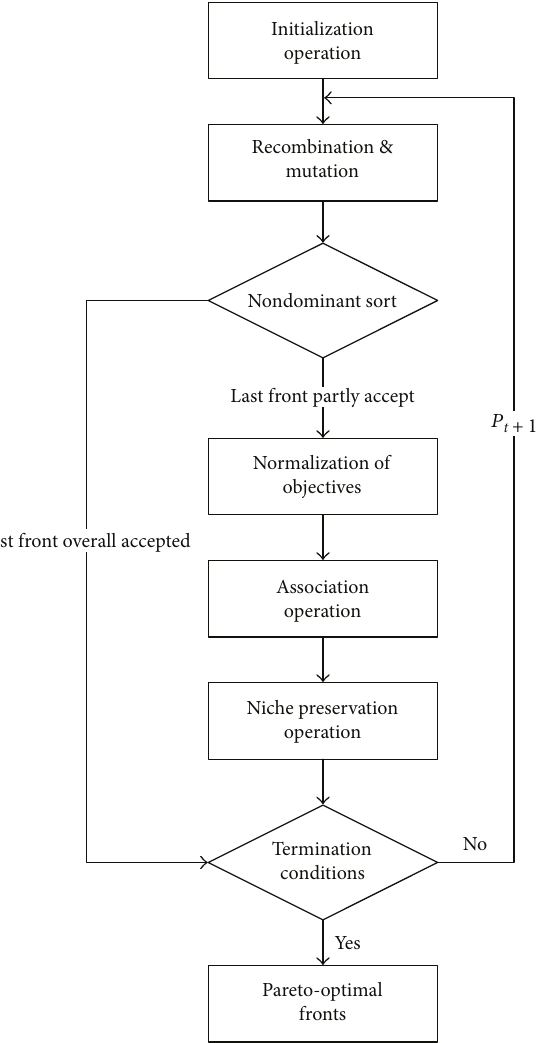
Figure 3: A fl ow chart of the NSGA-III